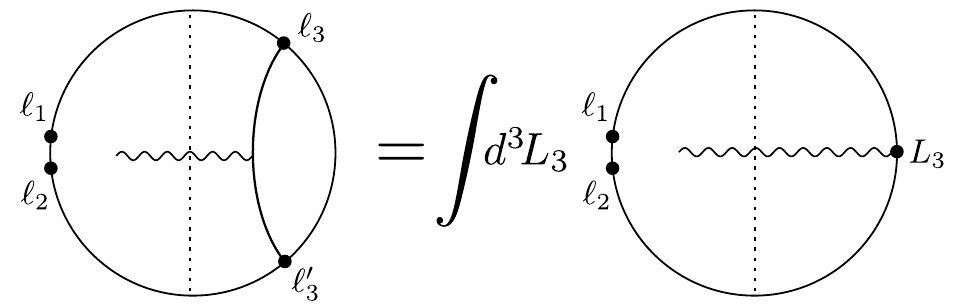
Figure 6 . An intermediate step in the radial locality argument. To the left of the dashed hyper- surface Σ , the DV field of γ is source-free, and can be written (up to gauge) as a superposition of 3 boundary-bulk